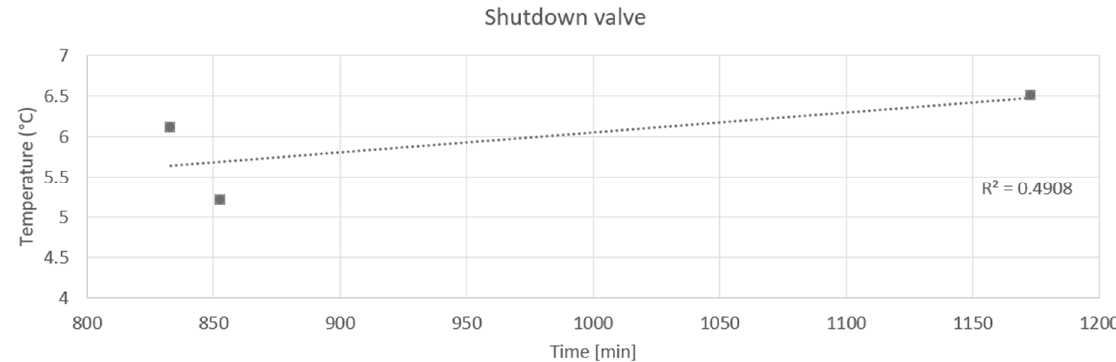
Figure 15. Three shutdowns showing temperature difference versus duration of temperature decline for the shutdown